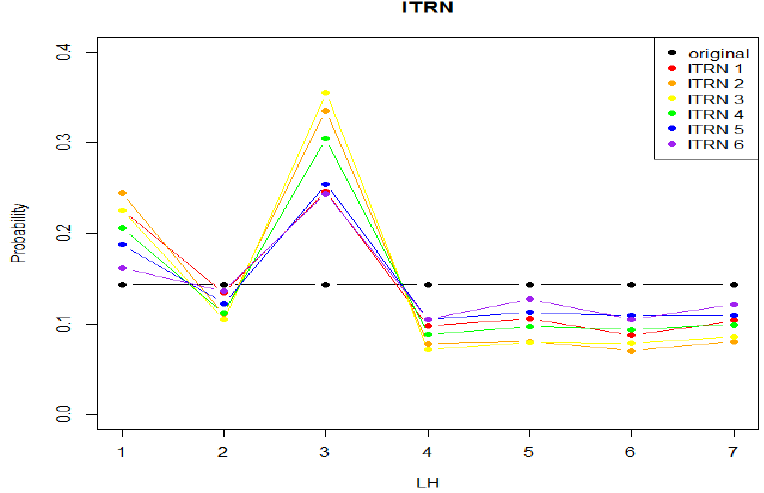
Figure 4. Variations in probabilities of low-level heuristics.